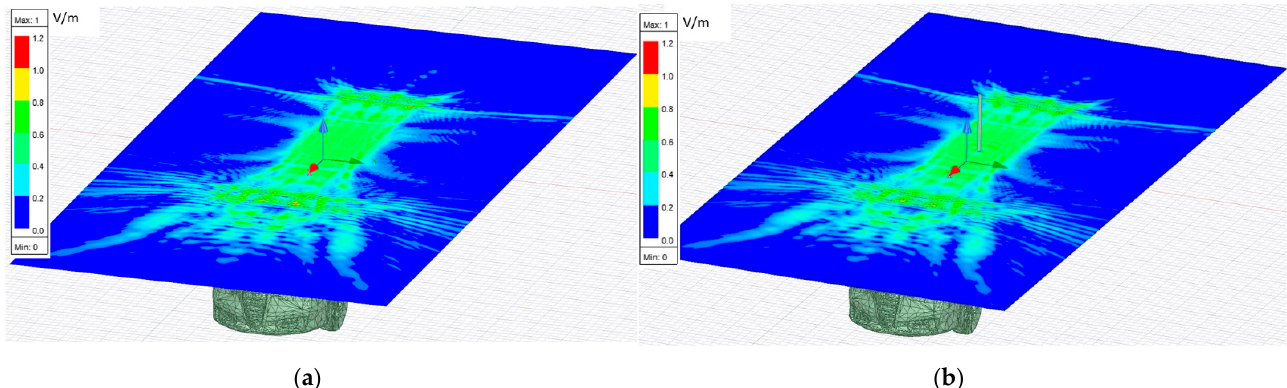
Figure 6. Pictorial representation of the near electric field on a plane in contact with the top of the car for the two simulation cases generated by Ansys HFSS software: ( a ) vehicle without an antenna installed at the top (OFF state); ( b ) vehicle with a monopole installed on the top (ON state).